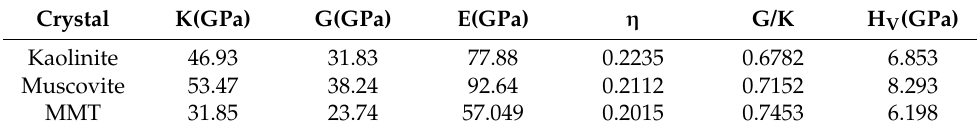
Table 3. The calculated bulk modulus (K), shear modulus (G), Young’s modulus (E), Poisson’s ratio